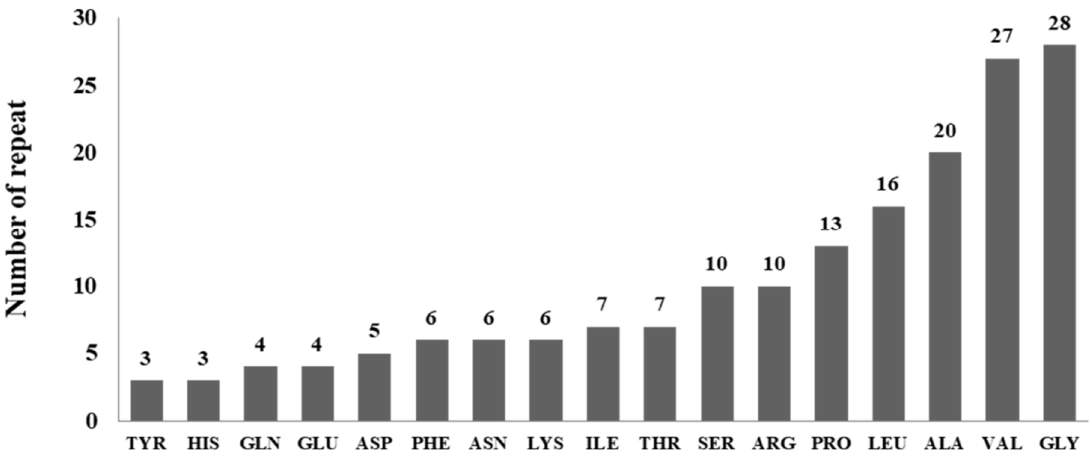
Figure 6. Residues preferences of conserved regions.